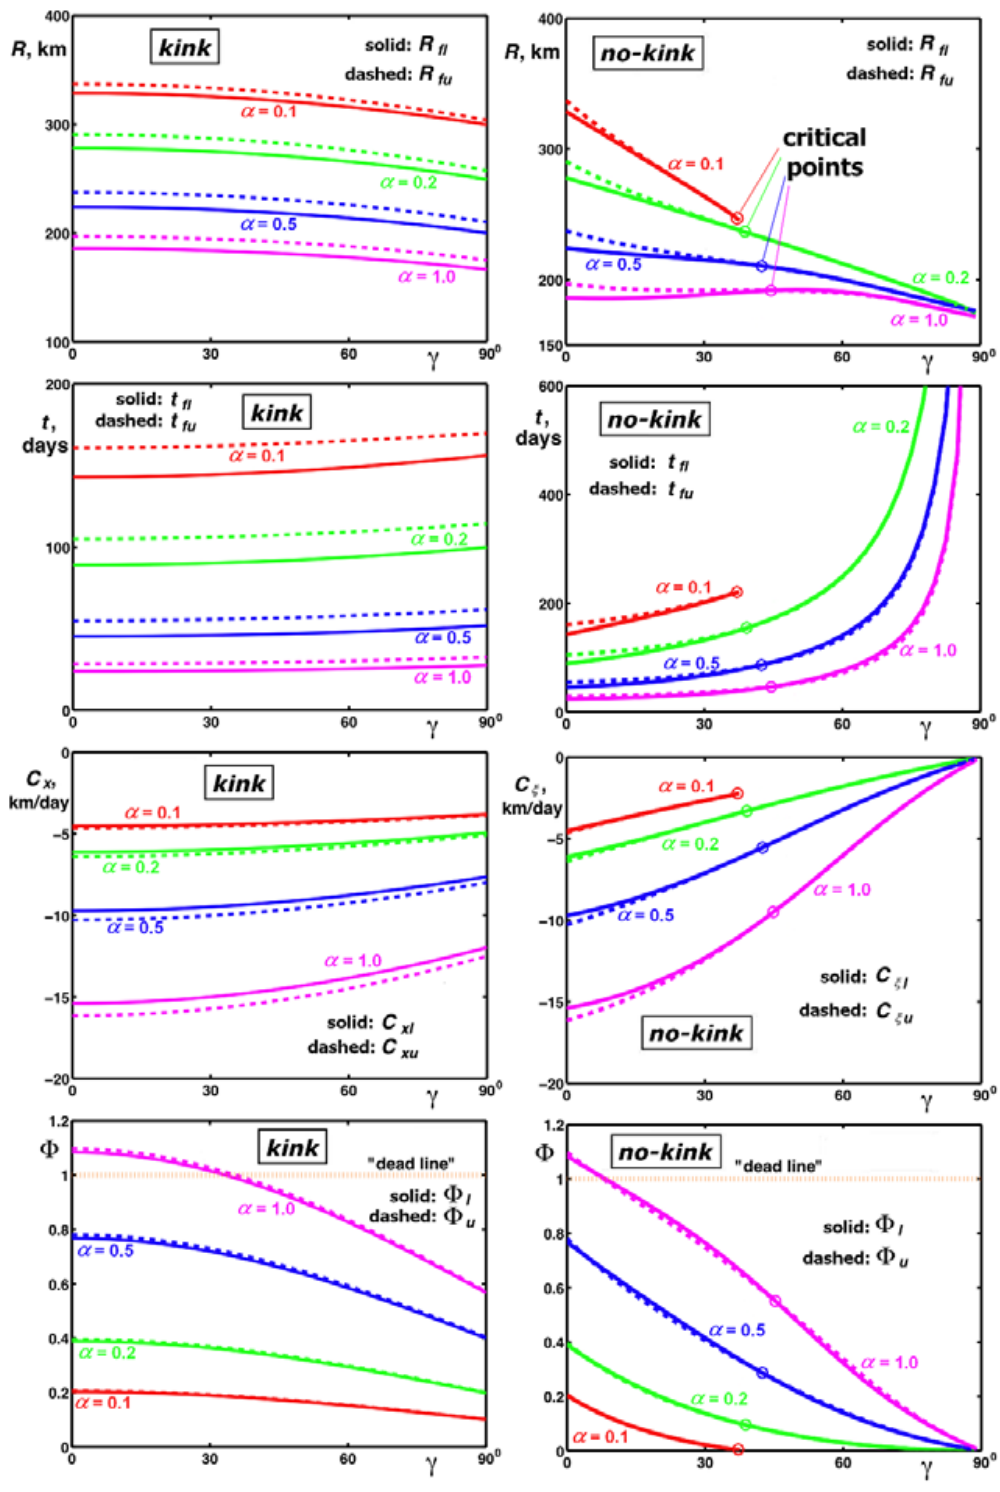
Fig. 5. Final base eddy radii ( R fl and R fu ), ring generation periods ( t fl and t fu ), ring zonal propagation rates ( C xl and C xu ), and mass flux ratios ( 8 l and 8 u ) as functions of γ for Concave I (left panels) and analogous ZNb model parameters (right panels, with non-zonal ring propagation rates C ξ l and C ξ u ), for h 0 = 300m and β = 2 . 3 × 10 − 11 m − 1 s − 1 . The curves are paired, where solid and dashed lines show the lower and upper boundaries of the eddy radius, respectively. In the Concave I case, upper and lower boundaries do not intersect. In the ZNb model, upper and lower boundaries do intersect, implying the existence of critical slant angles. Such critical points are circled.